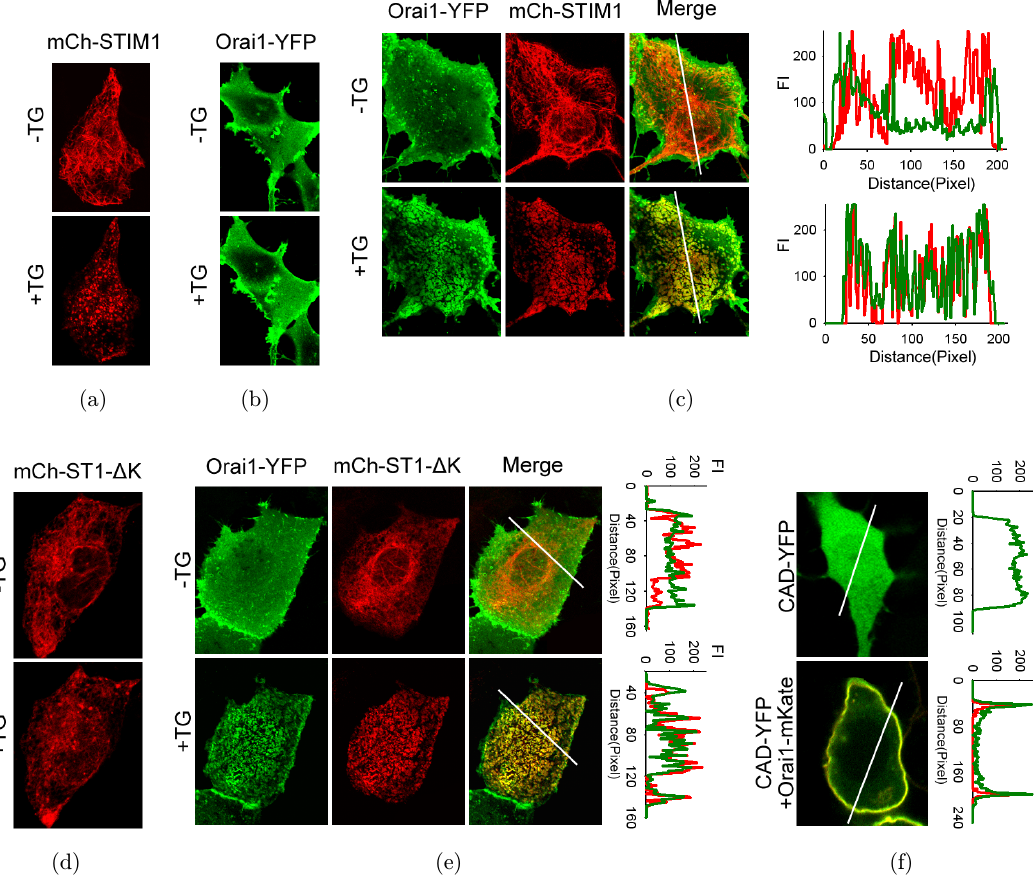
Fig. 1. STIM1 recruits to ER – PM junctions to form puncta through Orai1-dependent and -independent mechanisms. (a) De- pletion of the ER Ca 2 þ store with TG induces mCherry-STIM1 expressed alone in HEK293 cells aggregation into puncta under- neath the plasma membrane. After depletion, puncta are visible at the cell footprint. (b) Store depletion fails to evoke clustering of Orai1-eYFP when overexpressed alone as observed under confocal microscope in HEK293 cells. (c) When expressed together, mCherry-STIM1 and Orai1-eYFP form colocalized puncta after store depletion. The right panels show spatial pro¯les of °uores- cence intensity (FI) of Orai1-eYFP (green) and mCherry-STIM1 (red) along the lines imposed on the images. (d) mCherry-STIM1- Δ K expressed alone in HEK293 cells fails to form puncta after store depletion. (e) When expressed together, mCherry-STIM1- Δ K and Orai1-eYFP form colocalized puncta after store depletion. (f) CAD-eYFP is di®use cytoplasm distribution when expressed alone in a HEK293 cell (top), but the co-expression with Orai1 led to a dramatic recruitment of CAD-eYFP to the cell periphery (bottom). The right panels show spatial pro¯les of °uorescence intensity of CAD-eYFP (green) and Orai1-mKate (red) along the lines imposed on the